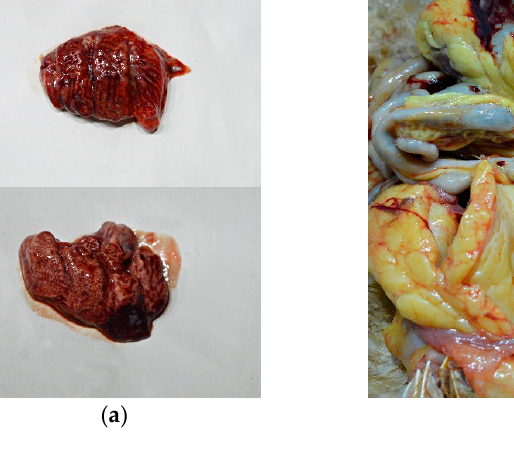
Figure 4. Gross lesions in chickens naturally infected with HPAI H5N8. ( a ) Extensive congestion and hemorrhages in the pulmonary parenchyma. ( b ) Severely congested ovarian follicles.